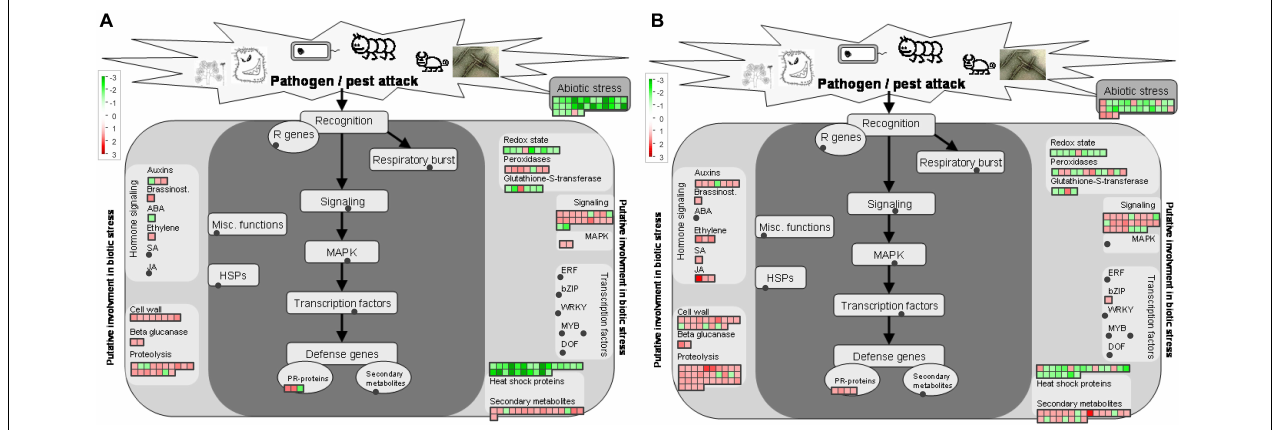
FIGURE 6 | Regulation of proteins involved in stress responses protein by Ca. L. asiaticus infection in leaf petioles. (A) Asymptomatic stage (CI1 vs. MI1) and (B) symptomatic stage (CI2 vs. MI2). Red squares, significantly upregulated proteins. Each colored square represents a single annotated gene in a particular pathway. No significantly upregulated proteins involved in ubiquitin-dependent protein degradation were observed in the asymptomatic